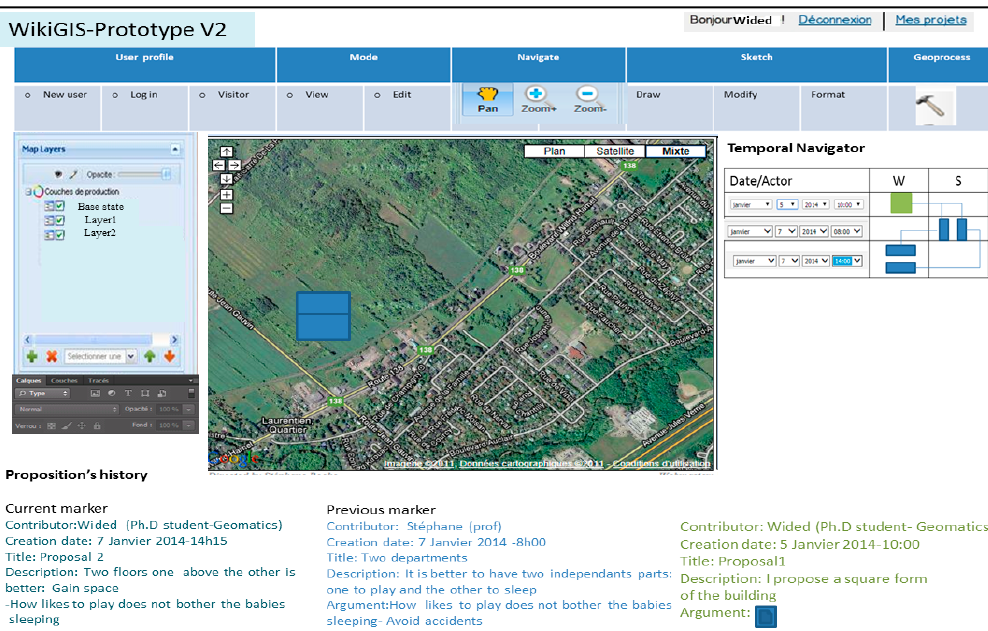
Figure 24. Third proposal in the